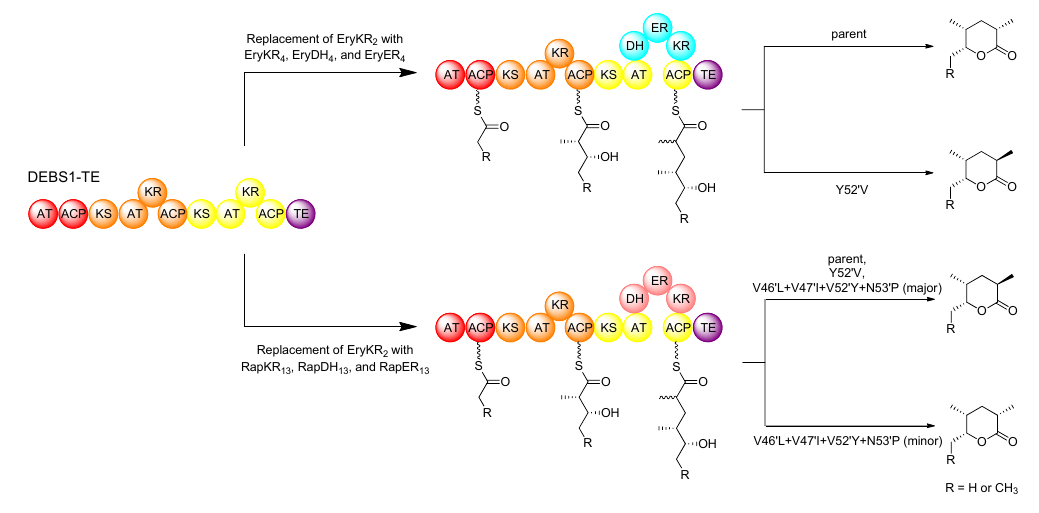
Figure 12. Domain swapping and mutagenesis with ERs in an intact PKS, resulting in altered product configuration